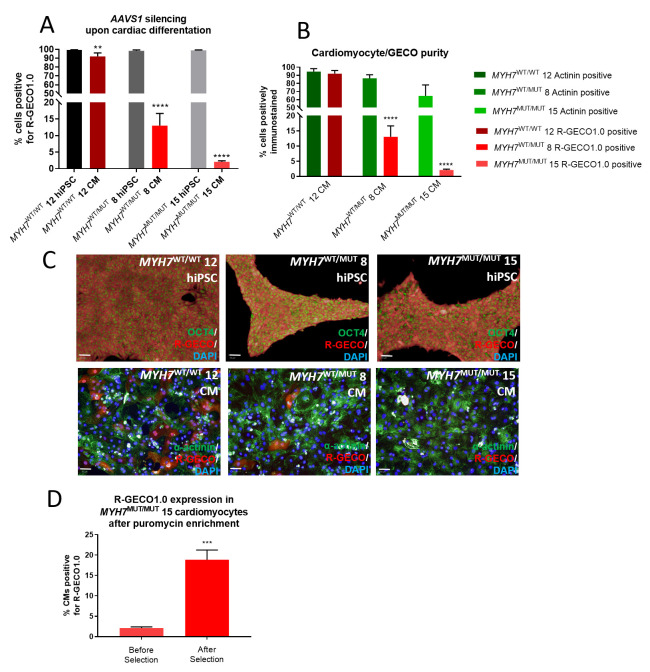
Changes in transgene expression during differentiation and antibiotic selection.(
A) Immunocytochemistry using an anti-RFP antibody to detect R-GECO1.0 expression shows a reduction in signal in
MYH7
WT/MUT 8 and
MYH7
MUT/MUT 15 cell lines upon differentiation from hiPSCs to hiPSC-CMs. Mean ±SD, n = 3 technical replicates. One-way ANOVA with Sidak’s multiple comparison test, ** p = 0.0015; **** p ≤ 0.0001. (
B) Percentage purity data for cardiomyocytes determined by alpha-actinin staining (green), for R-GECO1.0 by RFP staining (red). Mean ±SD, n = 3 technical replicates. One-way ANOVA with Sidak’s multiple comparison test, **** p ≤ 0.0001. (
C) Targeted hiPSC lines show variations in expression of R-GECO1.0 protein upon differentiation. hiPSC lines, identified by OCT4 staining (green, top row) show high R-GECO1.0 expression (red). Upon differentiation to cardiomyocytes, identified by α-actinin staining (green, bottom row),
MYH7
WT/MUT 8 and
MYH7
MUT/MUT 15 hiPSC-CMs show lower R-GECO1.0 expression (red). Scale bars = 50 µm. (
D) R-GECO1.0 expression in
MYH7
MUT/MUT 15 cardiomyocytes is significantly improved with three passages of hiPSC cell culture in 0.3 µg/ml puromycin and differentiation carried out in media supplemented with puromycin. Mean ±SD, n = 3 technical replicates. Unpaired t-test, *** p = 0.0003.